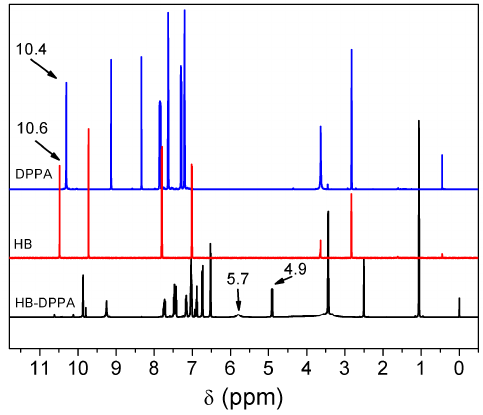
Figure 1. 1 H NMR spectra of DPPA, HB, and HB-DPPA.